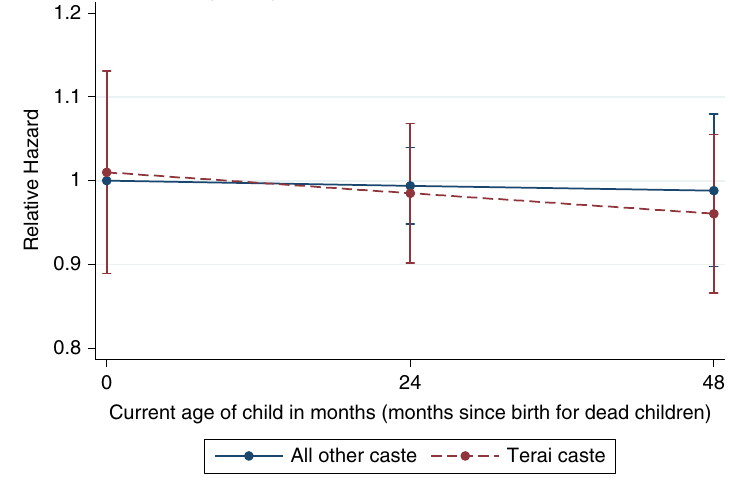
Figure 2. Predication of survival of child by caste of